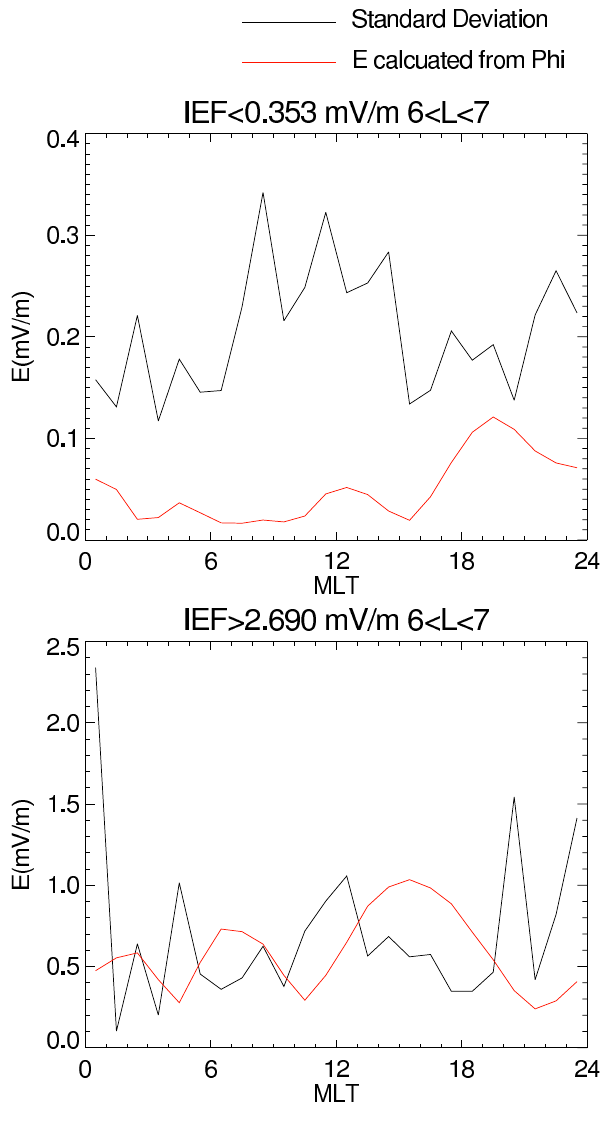
Fig. 9. Standard deviation between electric fields from our model and those from the original measurement mapped to the equator is shown by black lines. The magnitude of electric field from our model is shown by red lines. Top and bottom panels show the results at the smallest and largest IEF ranges, respectively. The results at 6 <L< 7 are organized by MLT which is indicated in the horizontal axis.